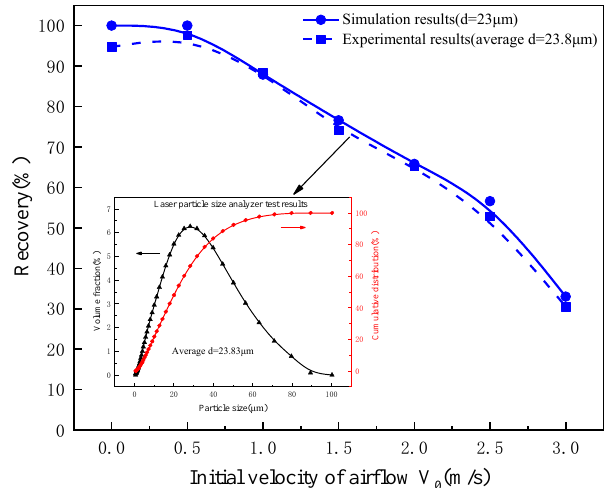
Figure 12. Variation of magnetic particle capture probability with air velocity under different remanence conditions: ( a ) B r = 1.0 T, ( b ) B r = 1.2 T, ( c ) B r = 1.4 T, and ( d ) B r = 16 T. Simulation results(d=23μm) Experimental results(average d=23.8μm)